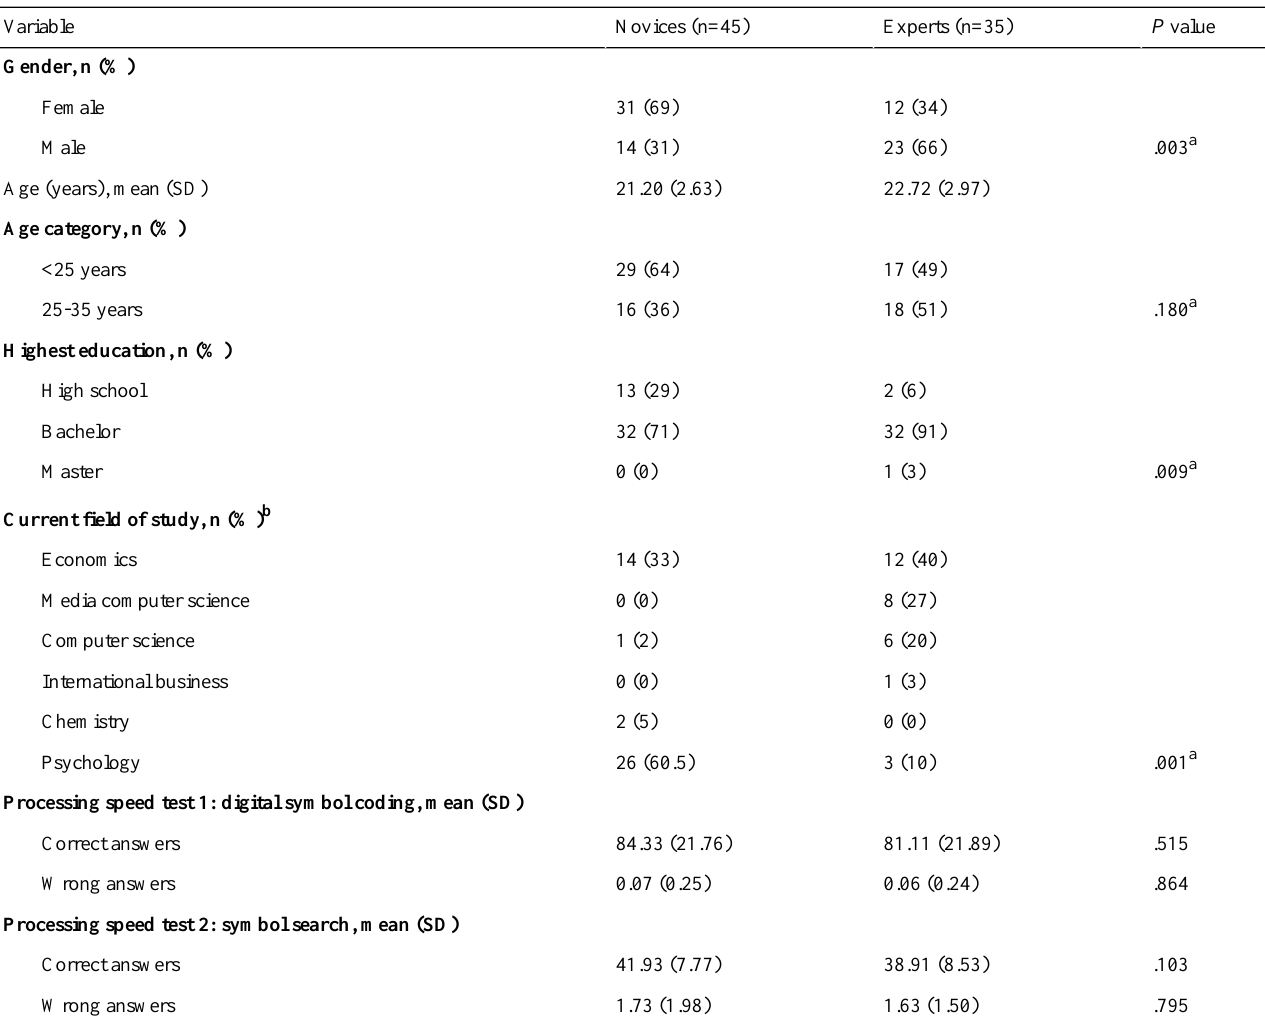
Table 3. Sample description and comparison between novices and experts in baseline